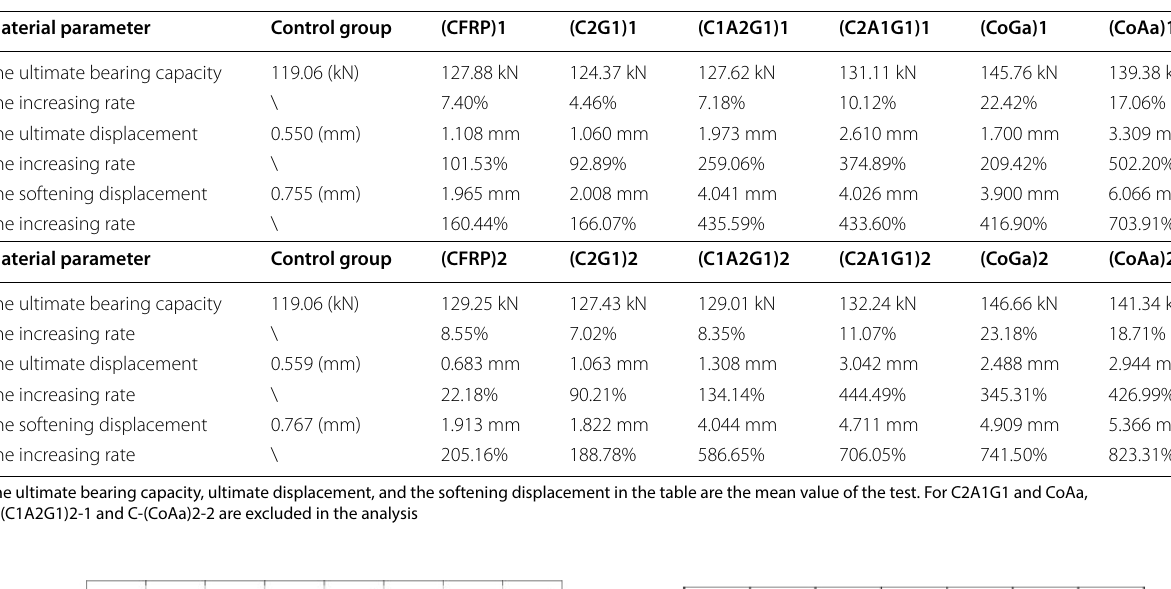
Table 6 Results of compression tests